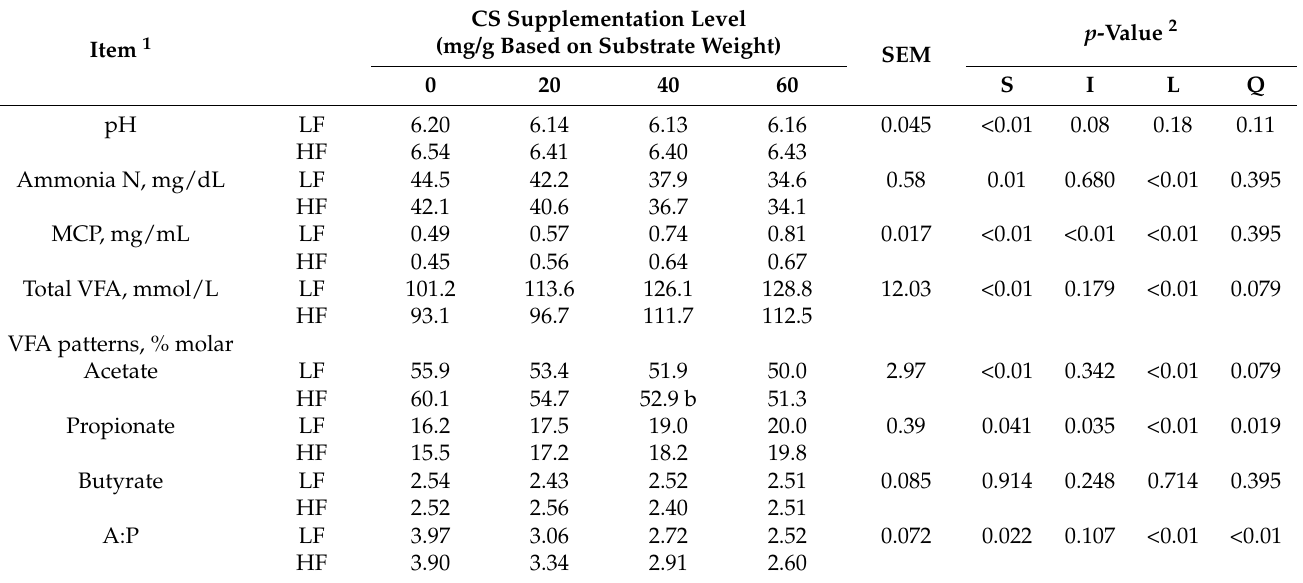
Table 3. Effects of different substrates and CS supplementation level on rumen fermentation charac- teristics.